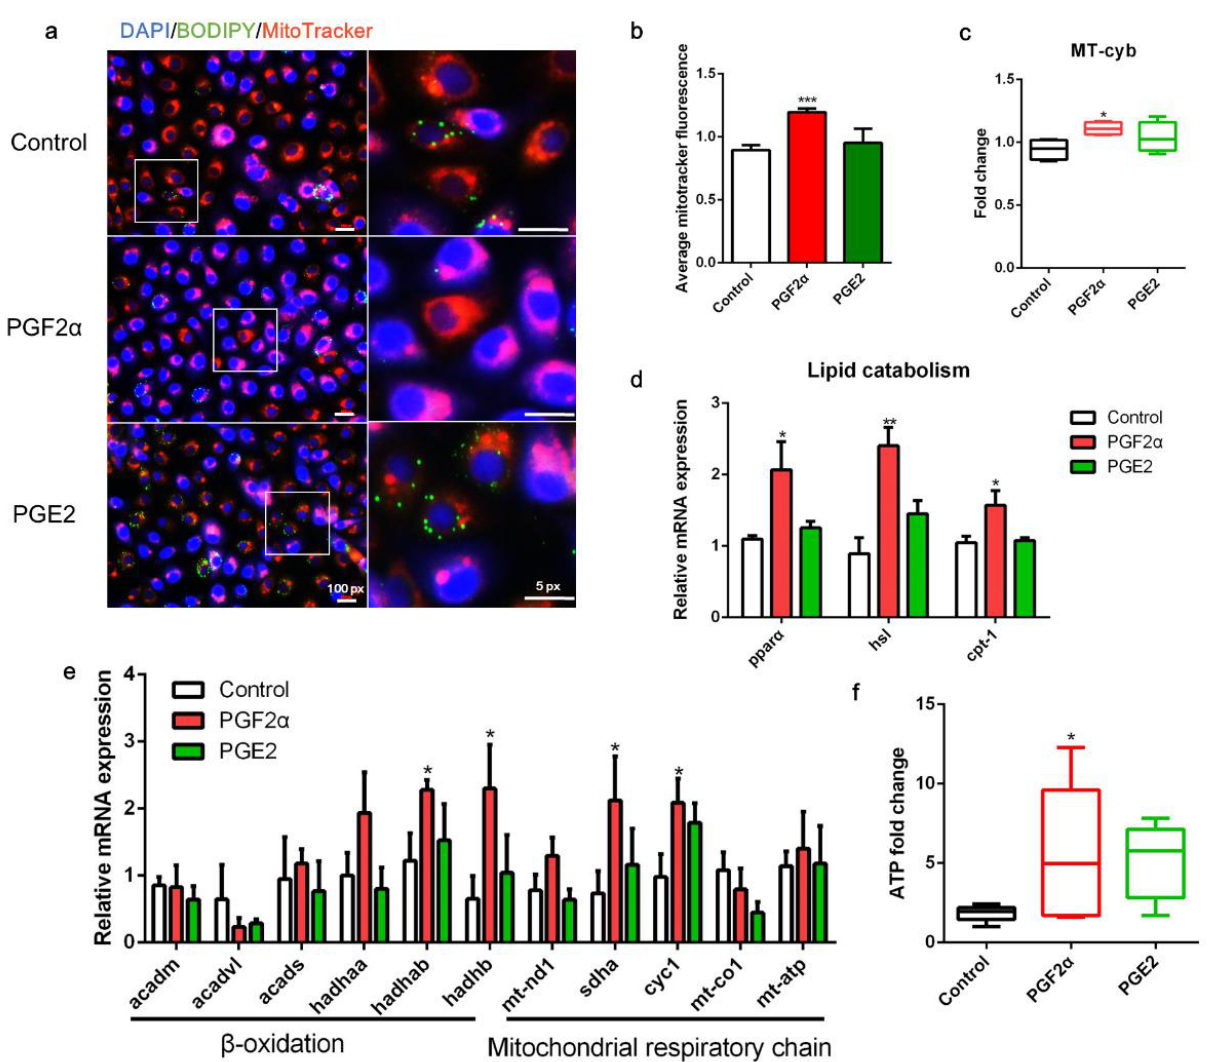
Figure 5. Effects of PGF2 α and PGE2 on mitochondrial function in zebrafish liver cells. Cells were incubated with or without PGF2 α (10 µ M) and PGE2 (10 µ M) for 24 h. ( a ) Lipid droplets were stained with BODIPY (green), nuclei were stained with DAPI (blue), and mitochondria were stained with MitoTracker (red). ( b ) Average MitoTracker fluorescence per cell ( n = 3). ( c ) Mitochondrial copy number ( n = 4). ( d ) Relative transcript expression of lipid catabolism-related genes ( n = 3). ( e ) Relative transcript expression of β -oxidation- and mitochondrial respiratory chain-related genes ( n =